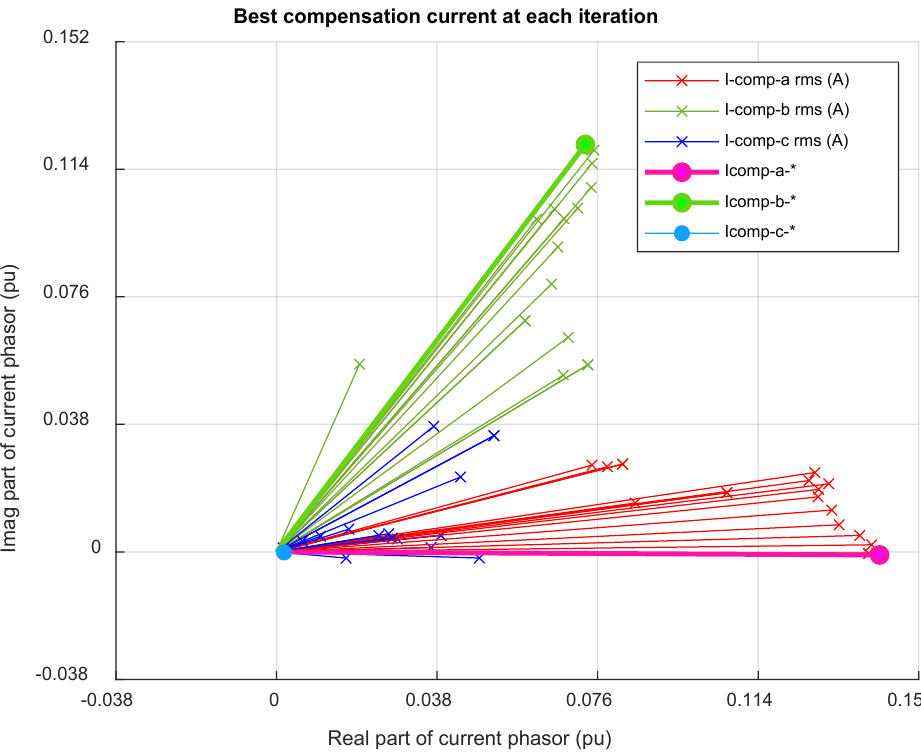
Figure 6. Best compensation current of each iteration in Case A. Table 3. Voltage unbalanced factor and voltage variation in Case